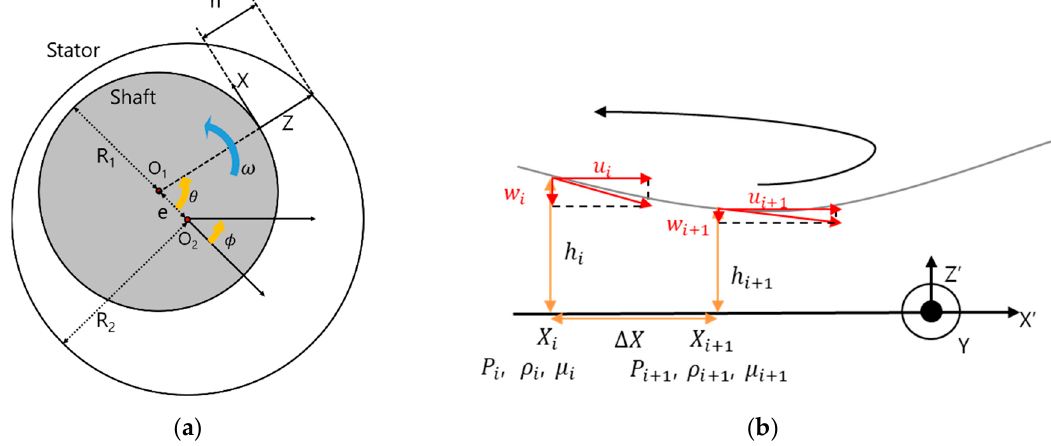
Figure 4. Geometry of the unbalanced shaft and the stator: ( a ) geometry description; ( b ) coordinate system for the finite difference method (FDM).